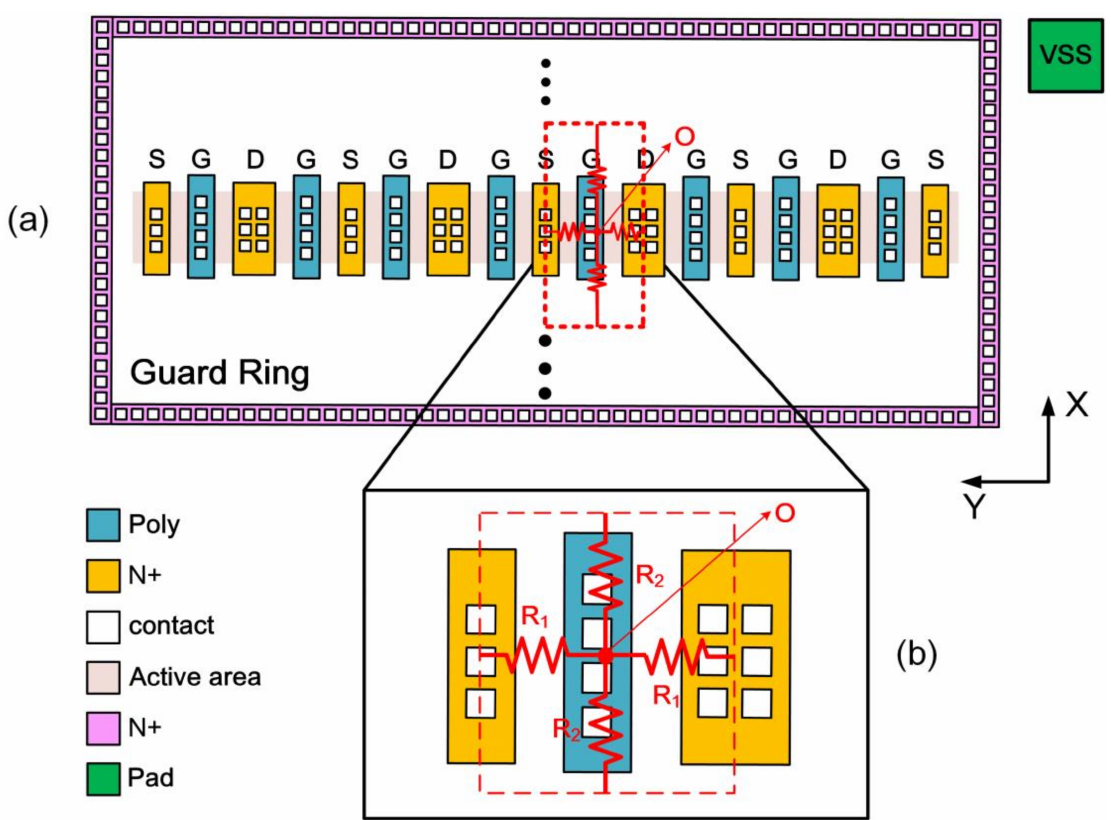
Figure 7. ( a ) Equivalent NMOS finger substrate resistance network of 8-finger example layout; ( b ) substrate resistance network for a single NMOS